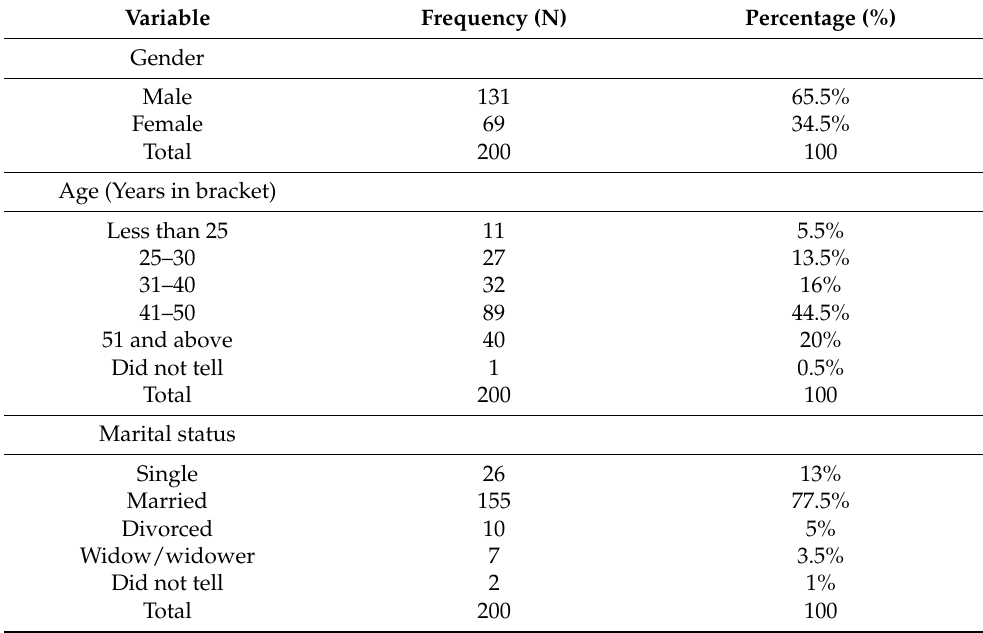
Table 2. Demographic characteristics of respondents in the